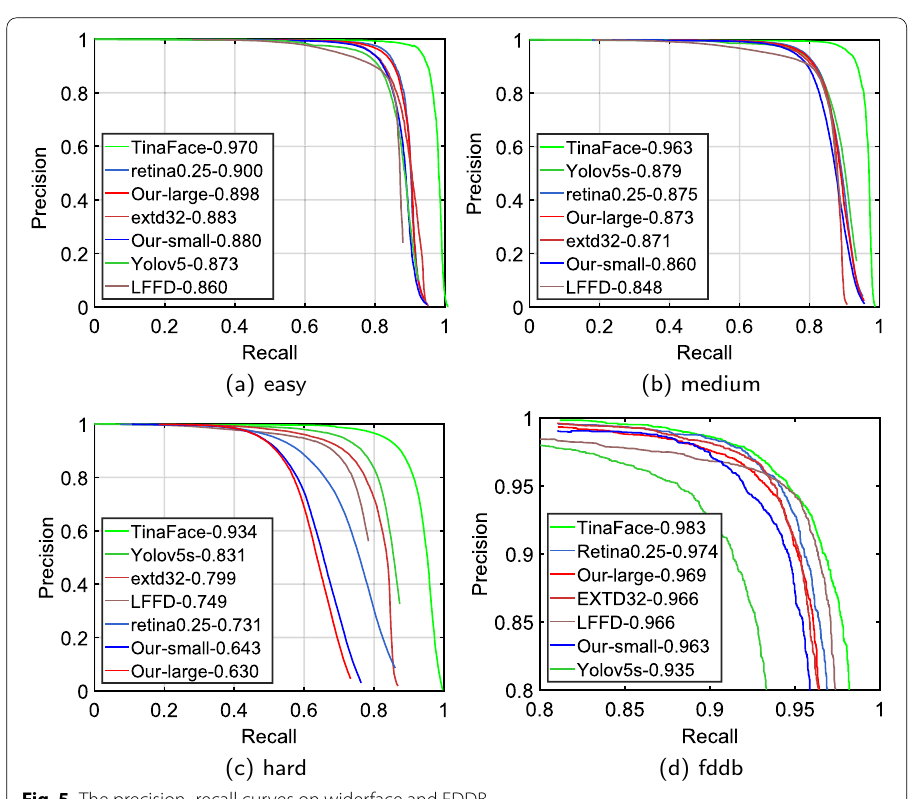
Fig. 5 The precision–recall curves on widerface and